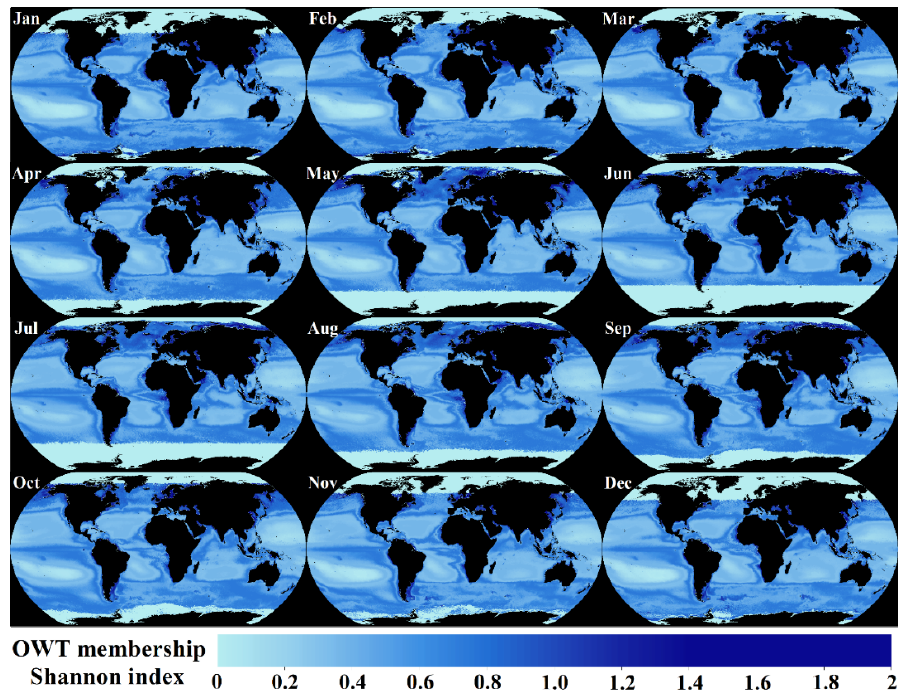
Figure 17. Global monthly variability in the U-OWT normalized membership Shannon index based on the ESA-OC-CCI v4.2 climatology monthly R rs (1998 − 2019).